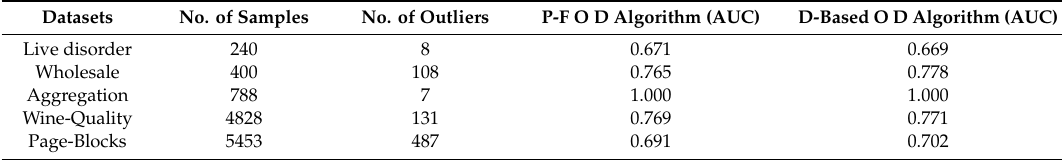
Table 6. Detection of real-world datasets by di ff erent outlier detection algorithms. Datasets No. of